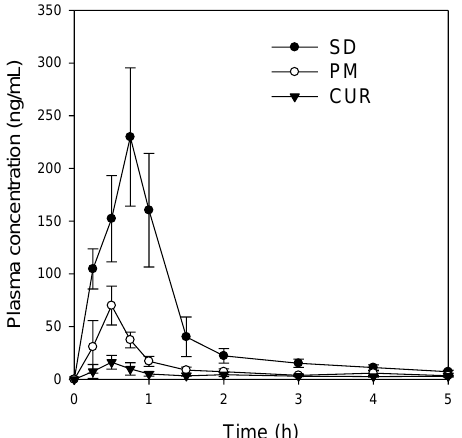
Figure 6. Plasma concentration-time profile of curcumin after oral administration of curcumin (CUR, ▼ ), physical mixture of curcumin:TPGS:mannitol = 1:10:15 (PM, ○ ), and solid dispersion formulation (SD, ). Curcumin suspended in 1% carboxymethyl cellulose was administered orally to rats at a dose of 200 mg/kg. Solid dispersion formulation and corresponding physical mixture (at a ratio of curcumin:TPGS:mannitol = 1:10:15) was administered orally to rats at a dose of 30 mg/kg. Each data point represents the mean ± S.D. of three to four rats.